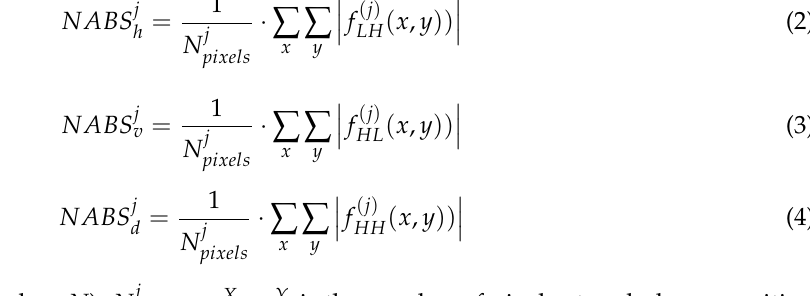
Table 1. Trend line equation coefficients and maximum variation ratios of the images in Figure 7.